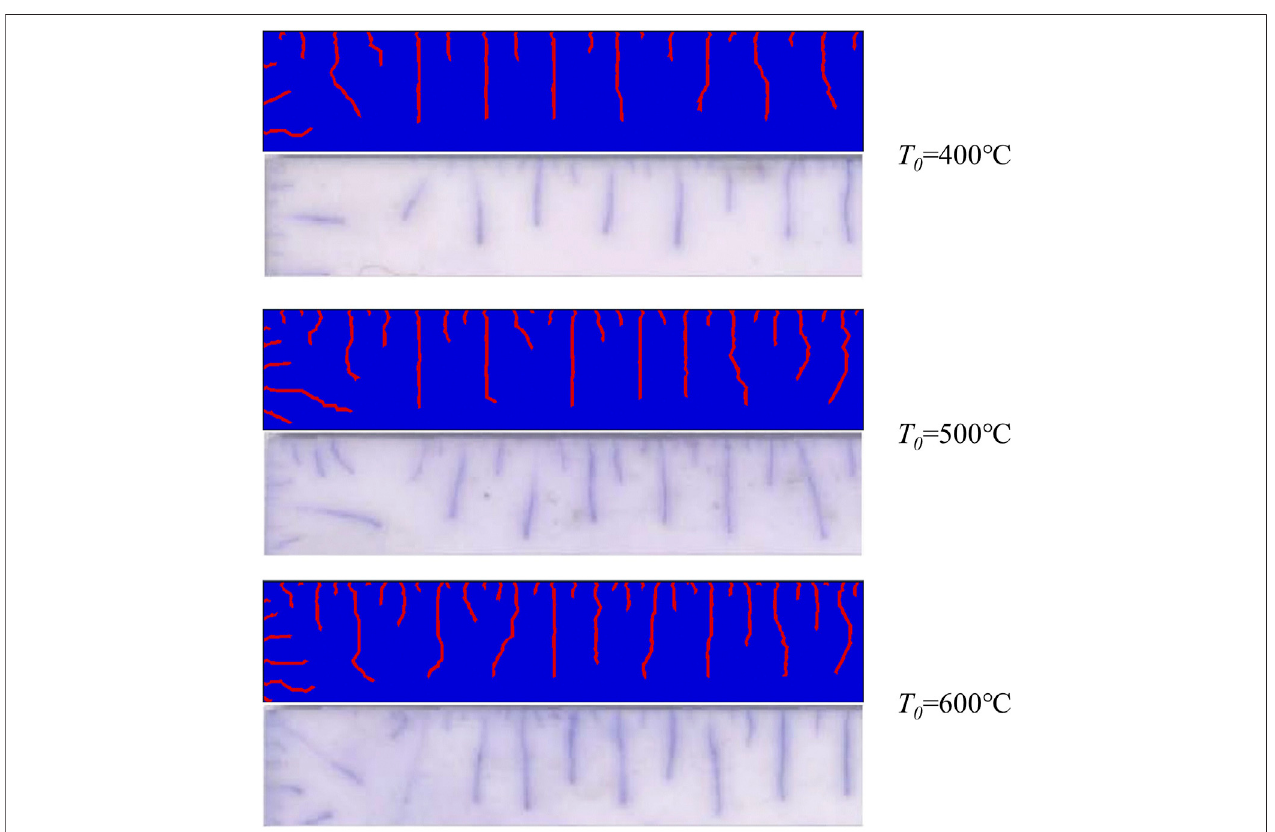
FIGURE 8 | Comparison of simulation results and experimental results (Jiang et al., 2012) of thermal shock in rectangle Al 2 O 3 specimens at different initial thermal shock temperatures.